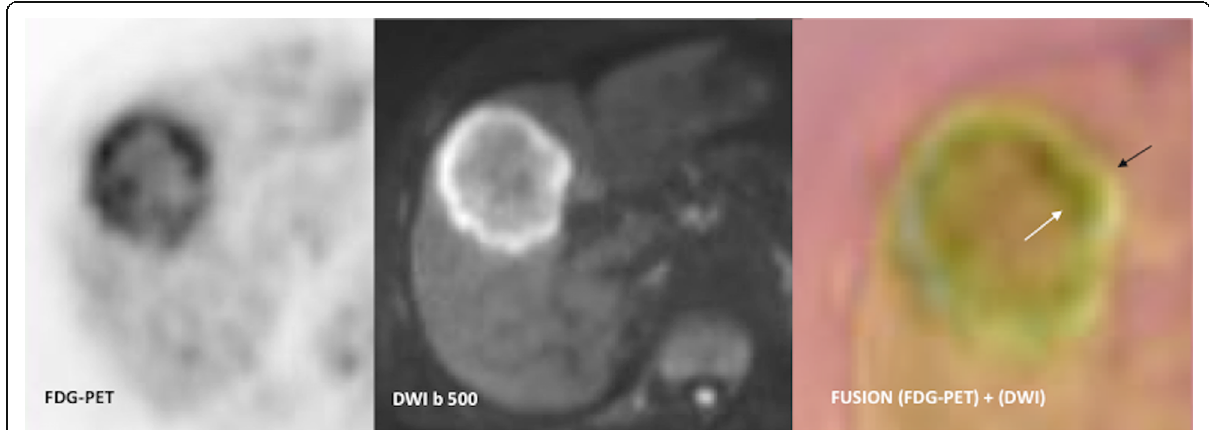
Fig. 21 Colorectal cancer liver metastasis in a 56-year-old man. FDG-PET (left) and b500 diffusion-weighted (middle) images demonstrated the presence of a mismatch between the obtained parameters. Note that the size of the FDG abnormality is smaller than the diffusion one (black arrow) (right). Tumor biology may explain this feature. Higher FDG uptake occurs at the edge of the necrotic cavity (white arrow) which is of relative low SI on b500 image. The edge of the necrotic cavity usually represents an area of relative tumor hypoxia, which may promote a high metabolic activity (vascular metabolic-mismatch). On its part, the periphery of the mass generally presents good perfusion and it is the most cellular area of the tumor, explaining the restricted diffusion at this